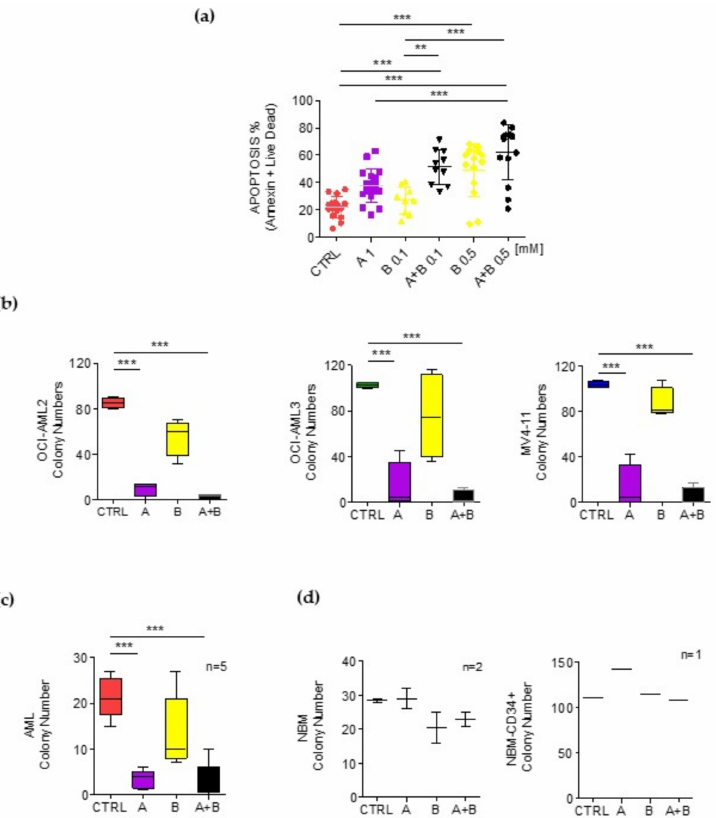
Figure 4. Effects of ascorbate and buformin on survival of AML blasts. Cells were treated with (A) ascorbate (1 mM) and (B) buformin (0.1 and 0.5 mM). ( a ) Cell death of primary blasts from